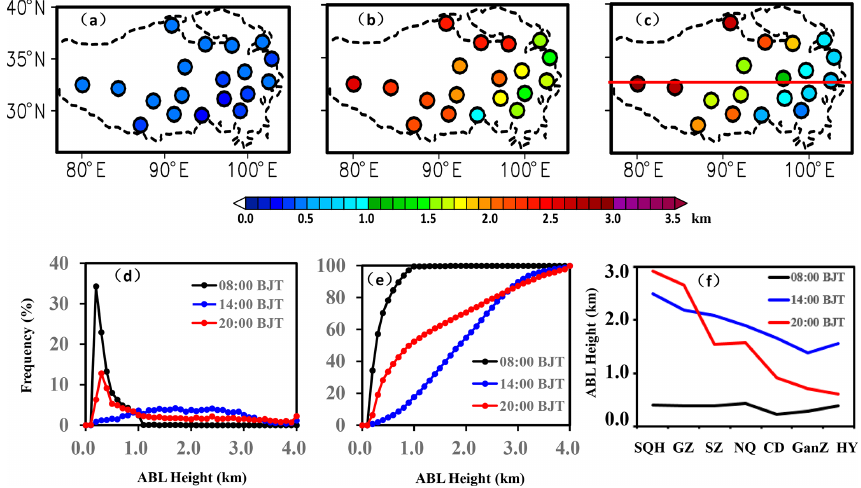
Figure 3. Spatial distribution of the mean ABL height (ABLH) at (a) 08:00BJT, (b) 14:00BJT, and (c) 20:00BJT; (d) the regional mean frequency and (e) cumulative frequency distributions of the ABLH in the TP at 08:00, 14:00, and 20:00BJT; (f) the west–east cross-sections of the ABLH along 32 ◦ N (indicated by red line in c ) at 08:00, 14:00, and